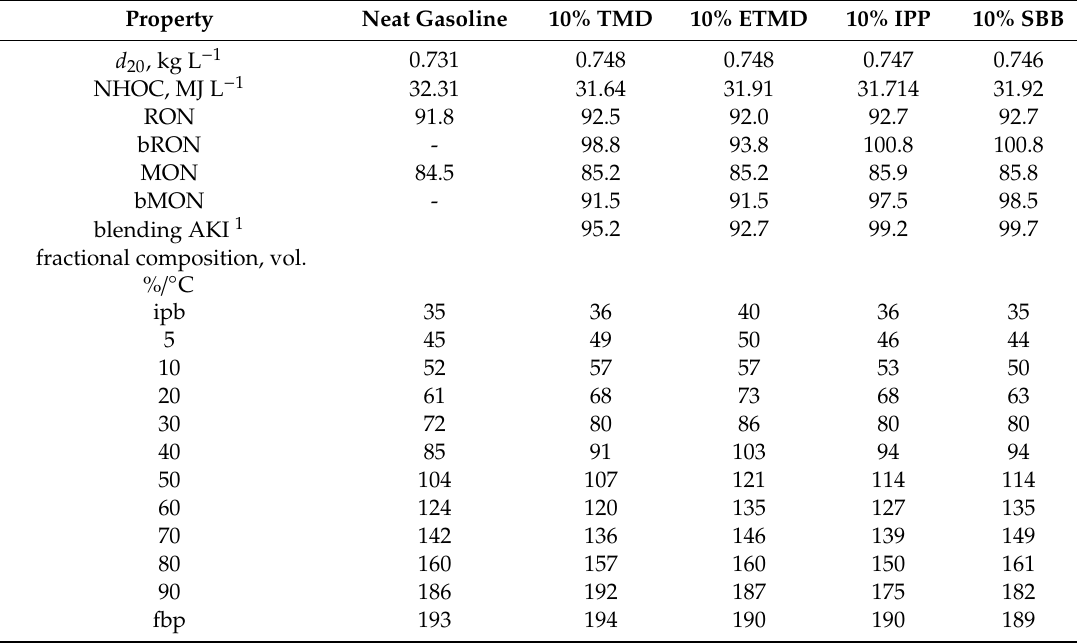
Table 15. The gasoline blending properties of 1,2-PD and 2,3-BD ethers and ketals.